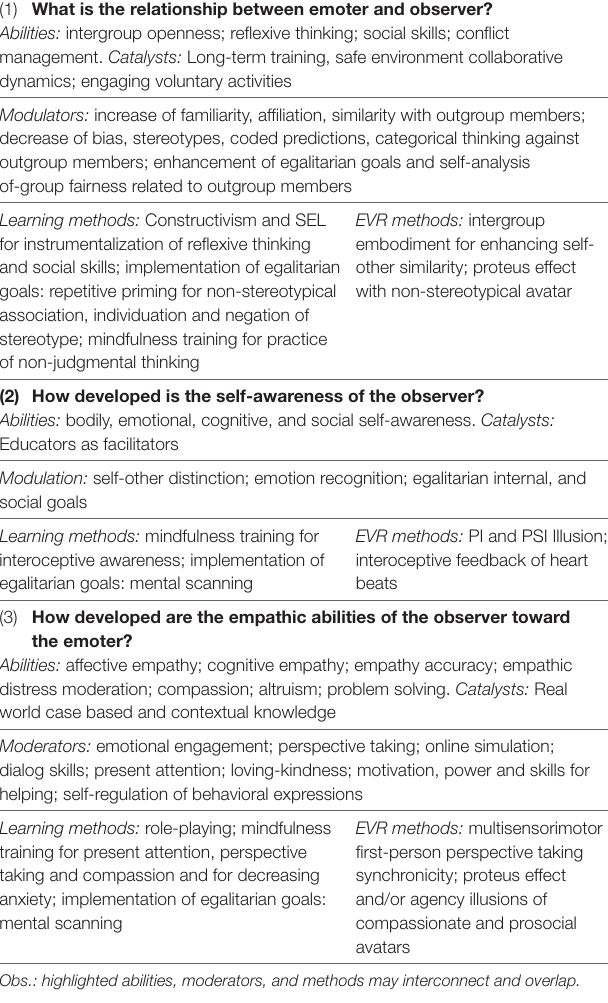
TABLe 6 | Framework for equalize empathic processes and expressions through learning methods and embodied virtual reality, based on highlighted concepts and